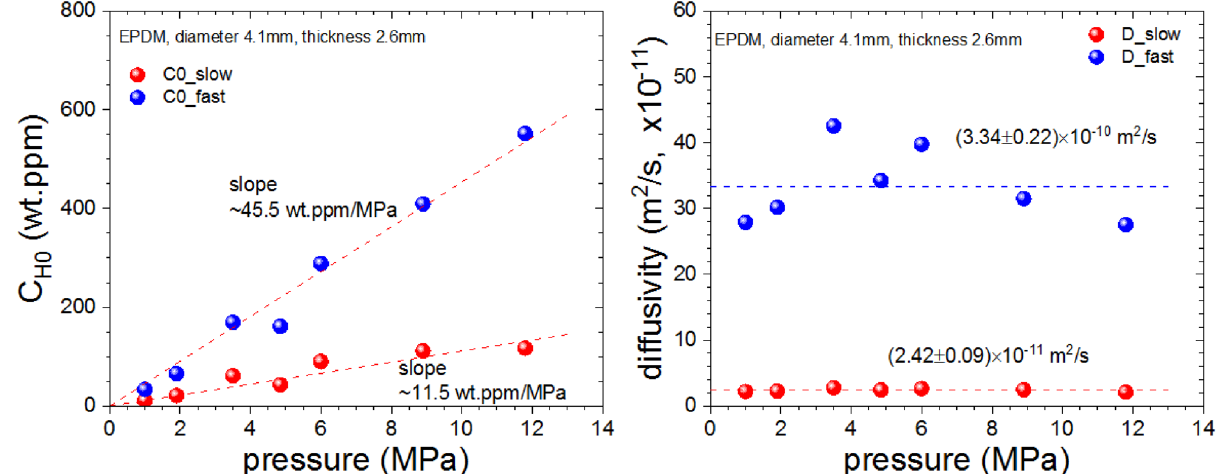
Figure 9. The content and diffusivity of the EPDM sample with CB filler versus pressure.